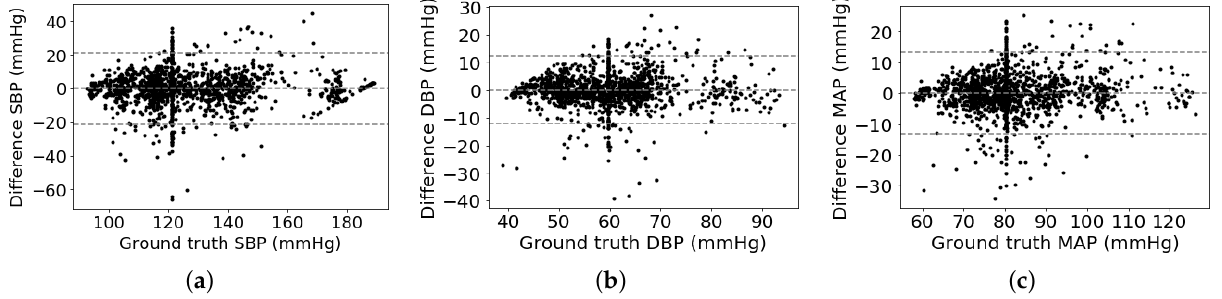
Figure 5. Variant Bland–Altman analysis plots: ( a ) systolic blood pressure (SBP), ( b ) diastolic blood pressure (DBP), ( c ) mean arterial pressure (MAP).